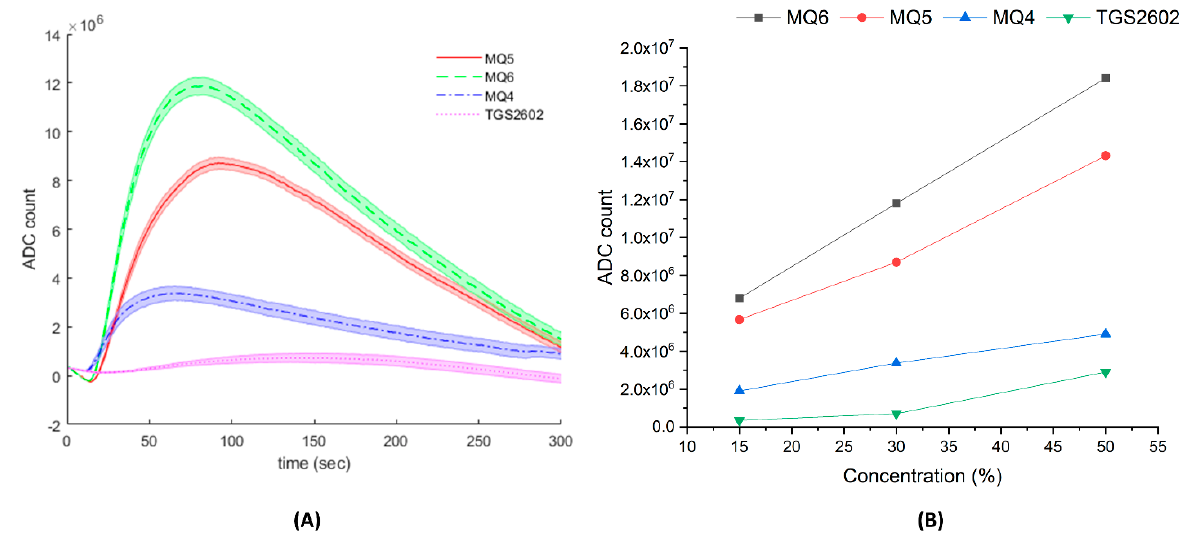
Figure 5. Calibration results using isopropyl alcohol. ( A ) Time-dependent sensor output for four modules (MQ4, MQ5, MQ6, and TGS2602) that showed significant response to the volatile sample of 35% isopropyl alcohol. The sample tray is positioned under the e-nose unit at time 0. ( B ) The response curve for three different concentrations. MQ6 and MQ4 show good linearity, with R2 values of 0.998 and 0.997, respectively.